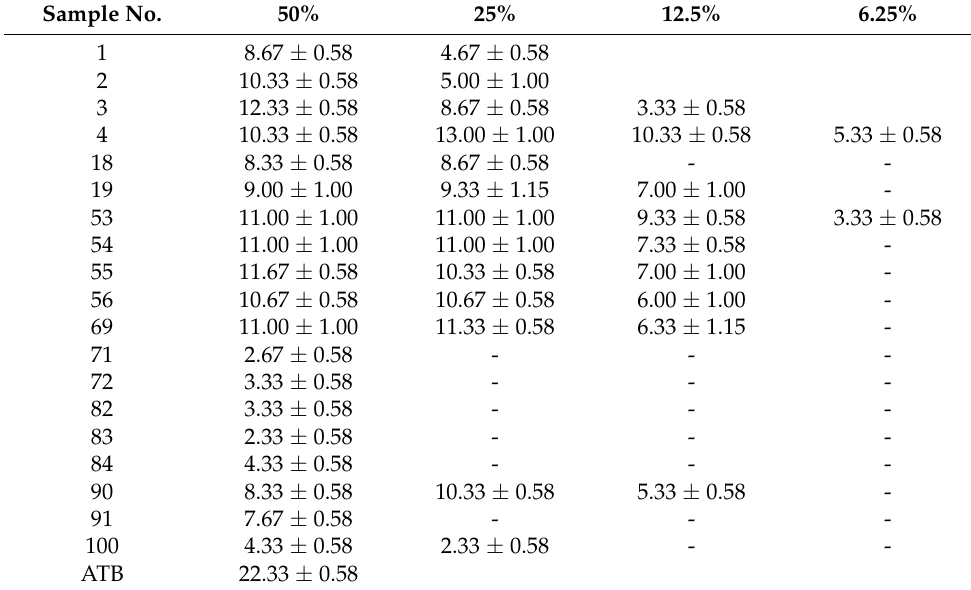
Table 4. Antimicrobial activity of samples against S. aureus in mm. Sample No.